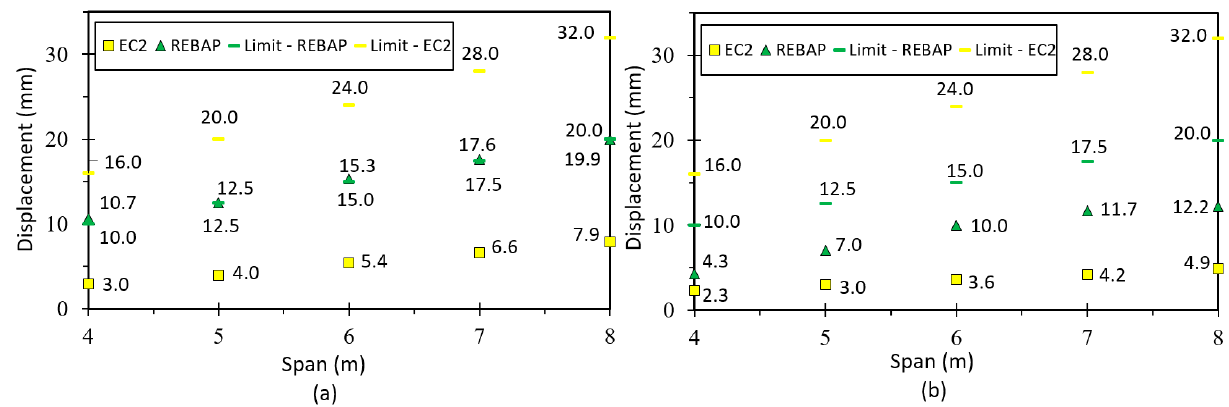
Figure 27. Deformation values of 2NLM: ( a ) analytical and ( b ) numerical, with their limit values, for supported beam.